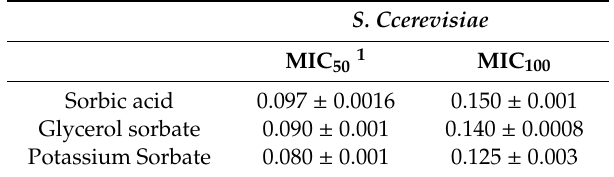
Table 3. Susceptibility of S. cerevisiae to sorbic acid and glycerol